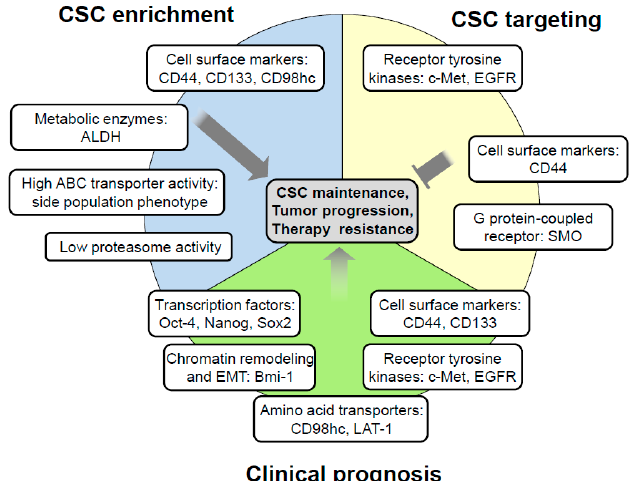
Figure 1. Selected markers for cancer stem cell (CSC) enrichment, targeting and prognostication in head and neck squamous cell carcinoma (HNSCC). Abbreviations: ALDH: Aldehyde dehydrogenases; ABC transporters: ATP-binding cassette transporters; CD98hc: CD98 heavy chain; EGFR: Epidermal growth factor receptor; EMT: Epithelial-mesenchymal transition; LAT1: L-Type Amino acid transporter 1; SMO: Smoothened, Frizzled class receptor.